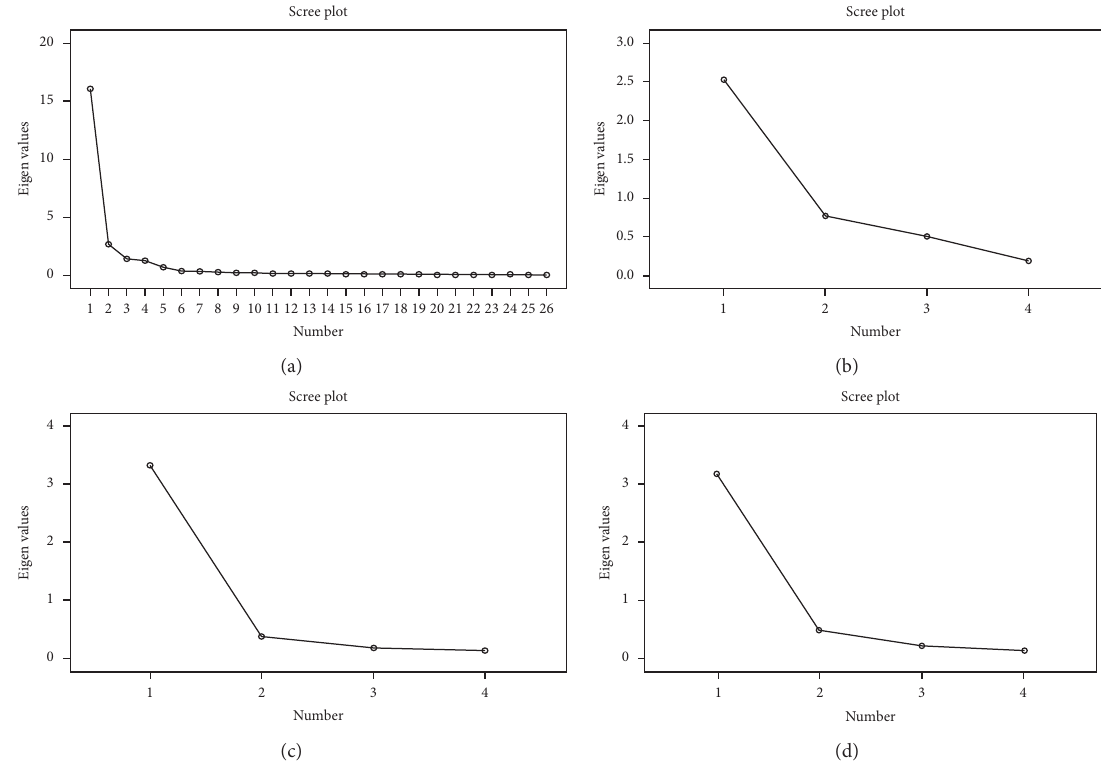
Figure 2: Scree plots of adolescent altruistic behavior (a), self-presentation (b), social ability cognition (c), and privacy awareness (d).